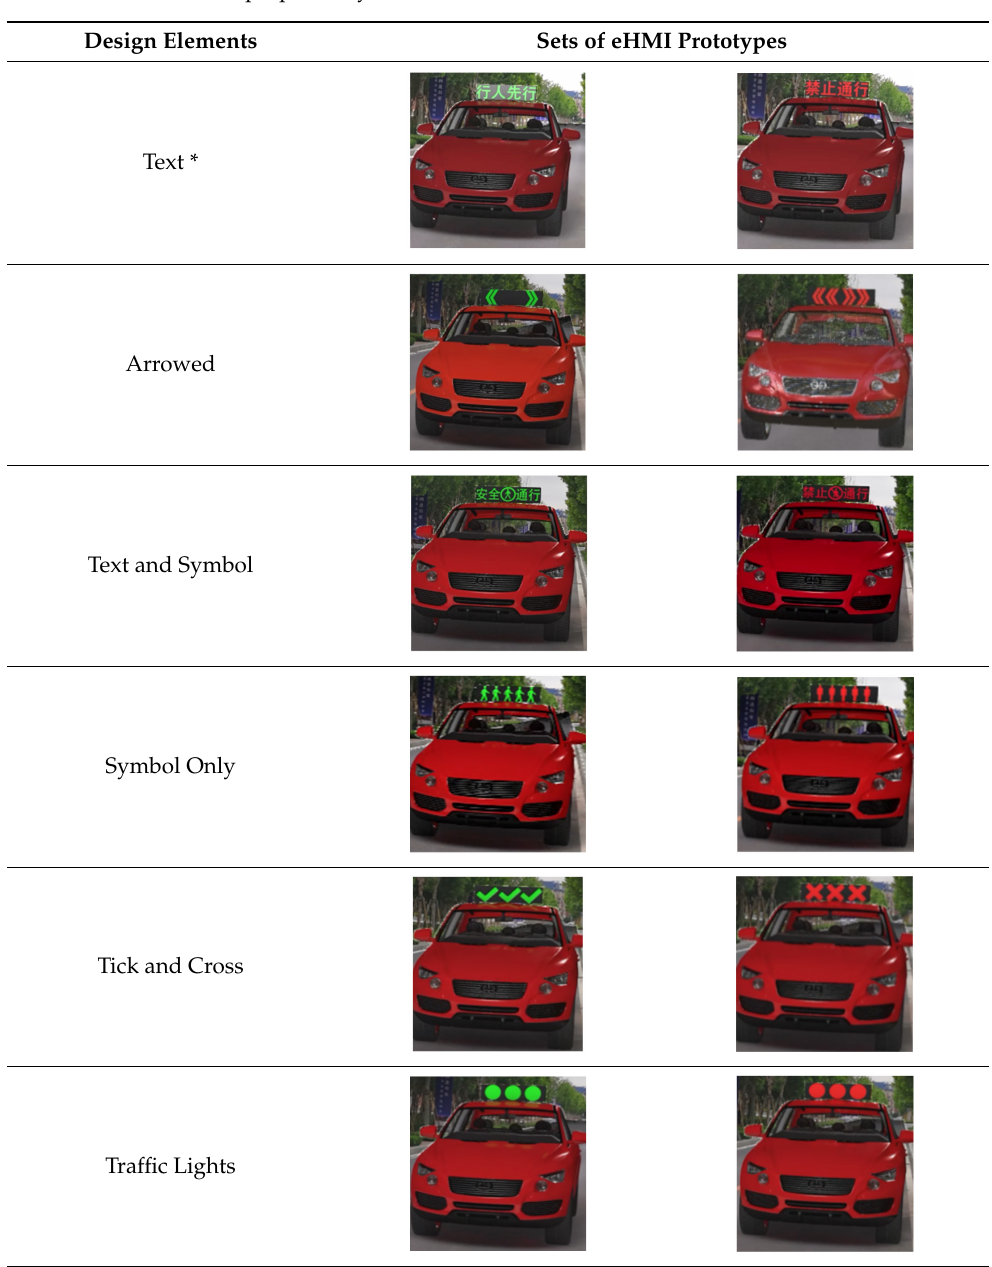
Table 1. eHMIs for AVs proposed by